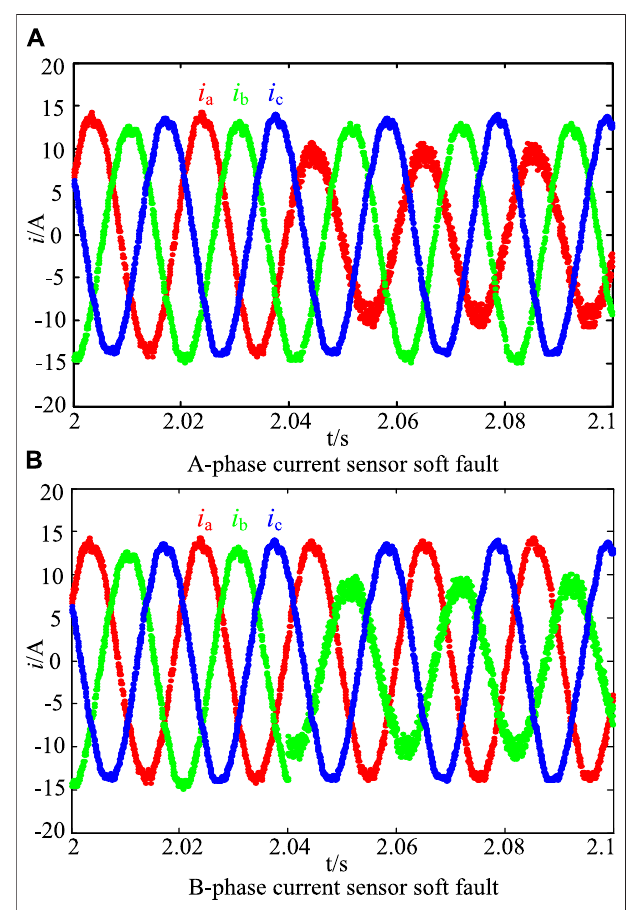
FIGURE 6 | Three-phase current data with current sensor soft